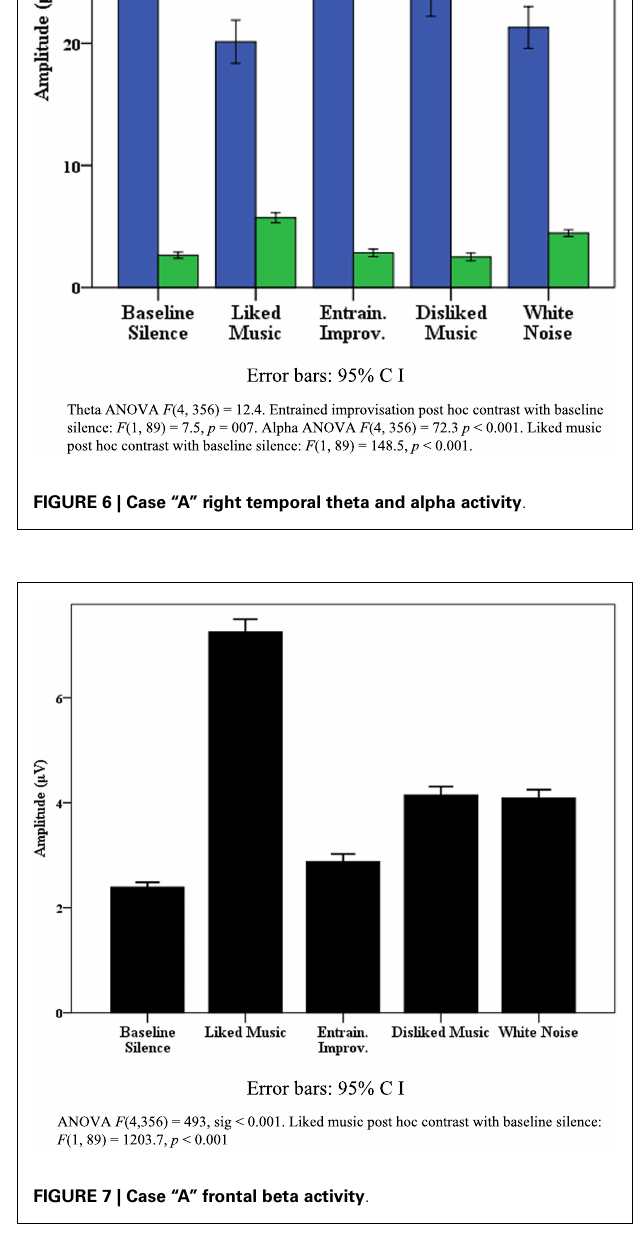
FIGURE 7 | Case “A” frontal beta activity